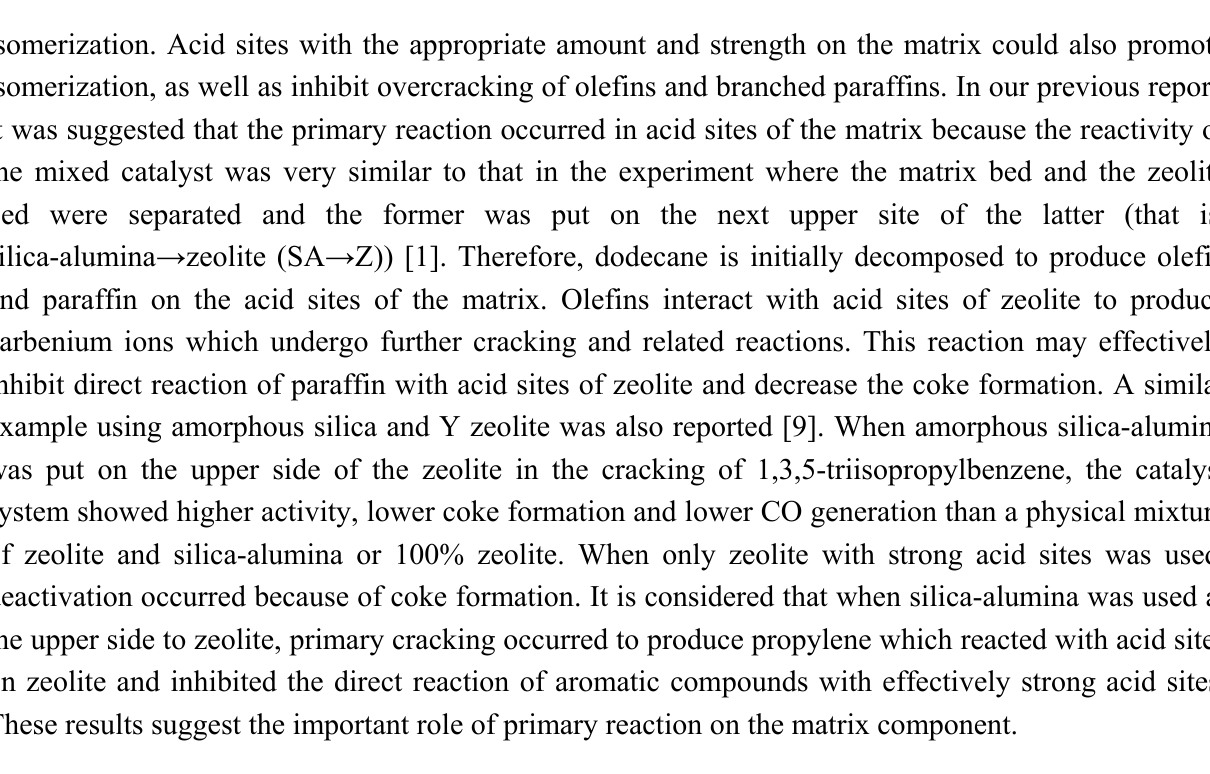
Figure 11. TEM images of silica, mixed catalyst and β